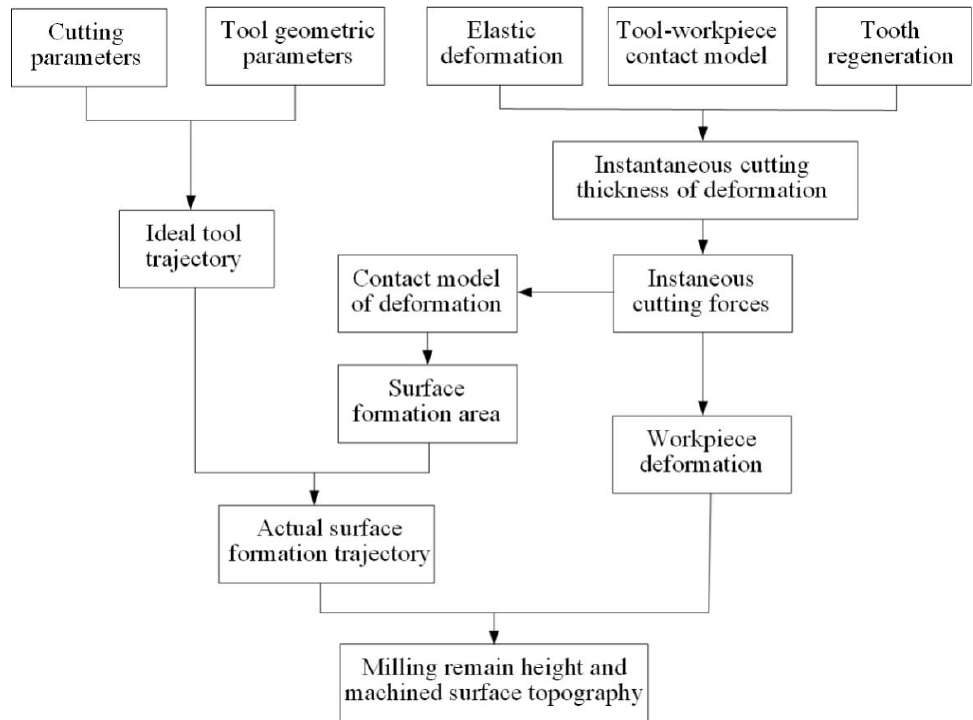
Figure 8. Milled surface topography